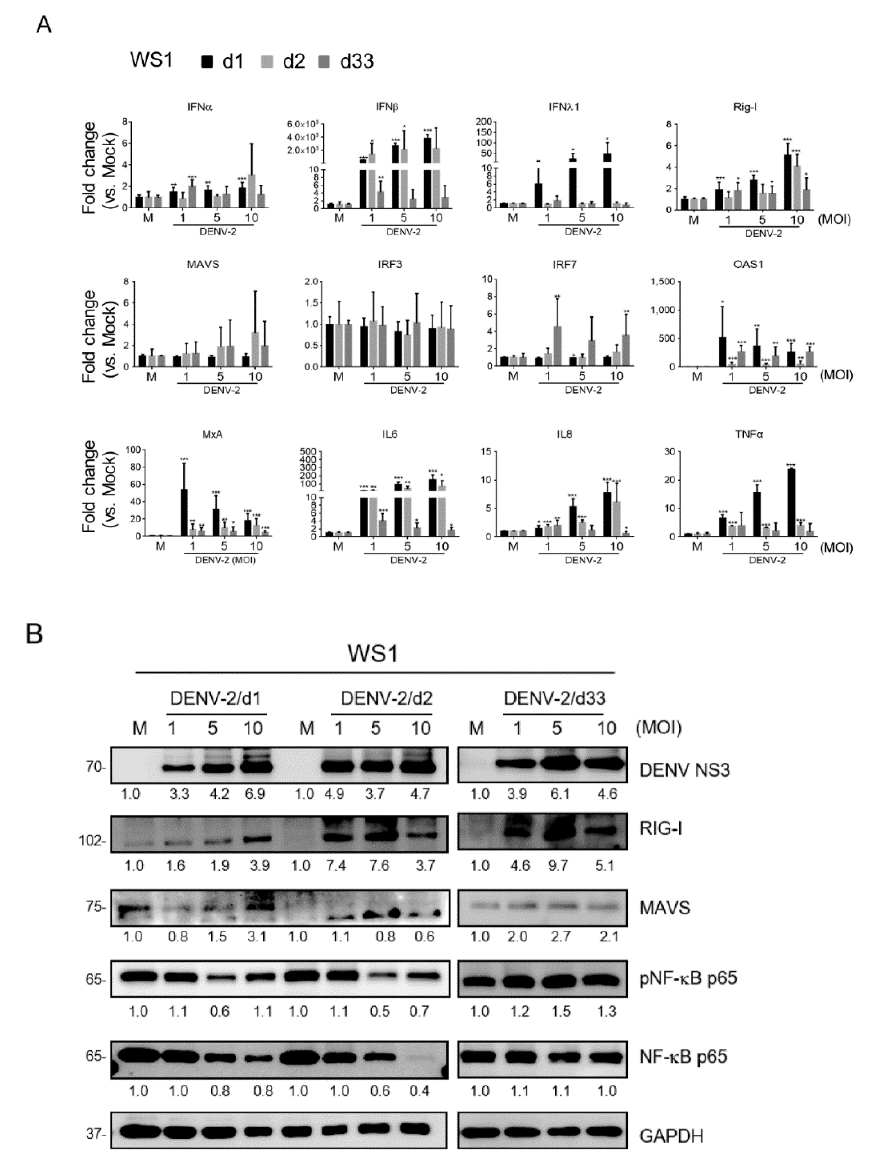
Figure 5. Prolonged DENV-2 induces anti-viral inflammation in WS1 cells. ( A ) qRT-PCR of the indicated antiviral inflammation genes’ mRNA expression in WS1 cells infected with DENV-2 at MOI 1, 5, and 10 for 1, 2, and 33 days. The gene expression was normalized to internal control gene, Gapdh . Data are presented as mean ± SD from three independent tests, * p < 0.05, ** p < 0.01, *** p < 0.005 vs. mock control. ( B ) WS1 cells were infected by DENV at MOI 1, 5, and 10 for 1, 2, and 33 days. The cell lysates were subjected to acrylamide sodium dodecyl sulfate polyacrylamide gel electrophoresis (SDS-PAGE) and Western blot analysis with antibody against DENV NS3, retinoic acid-inducible gene I (RIG-I), mitochondrial antiviral-signaling protein (MAVS), NF- κ B p65. GAPDH expression was the internal loading control. Data are presented from three independent tests. Quantification of each protein level with GAPDH was normalized to the mock